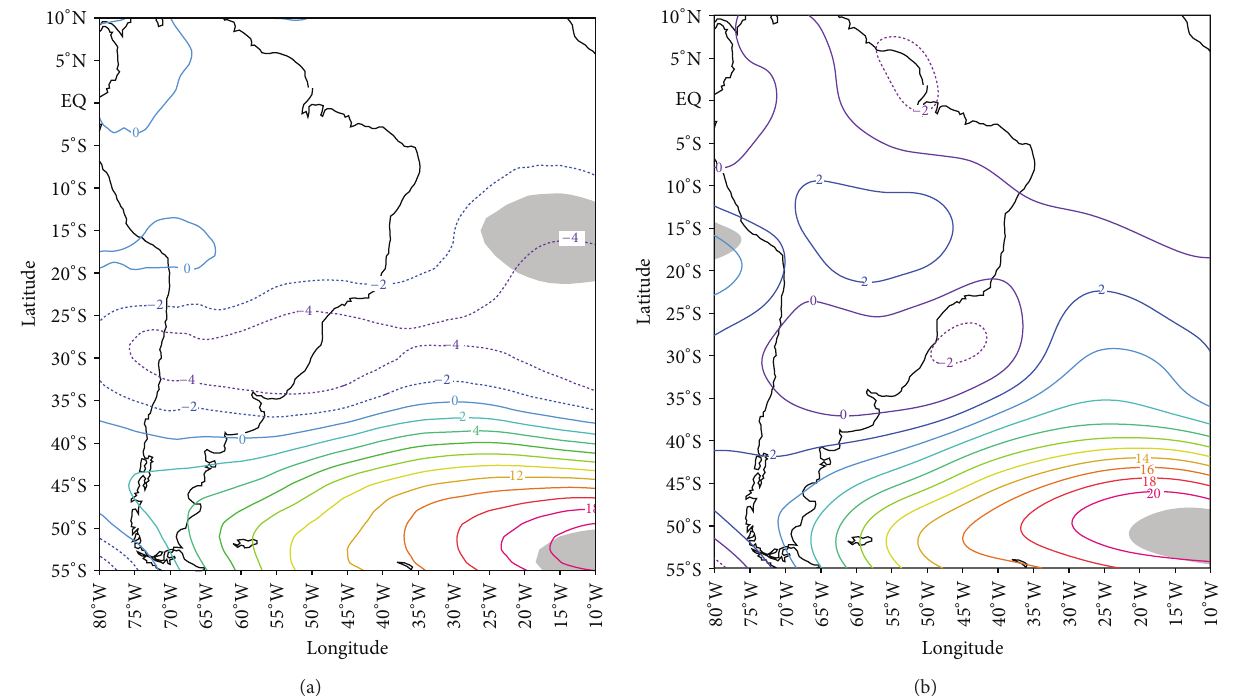
Figure 7: Annual mean geopotential height (m) anomaly for HCSA strong cases at 500 hPa in the period 1996–2011 based on the (a) Era- Interim reanalysis and (b) RegCM4 simulation. Contour intervals are 2m and significant values above 90% confidence level from two-tailed Student’s 𝑡 -test are